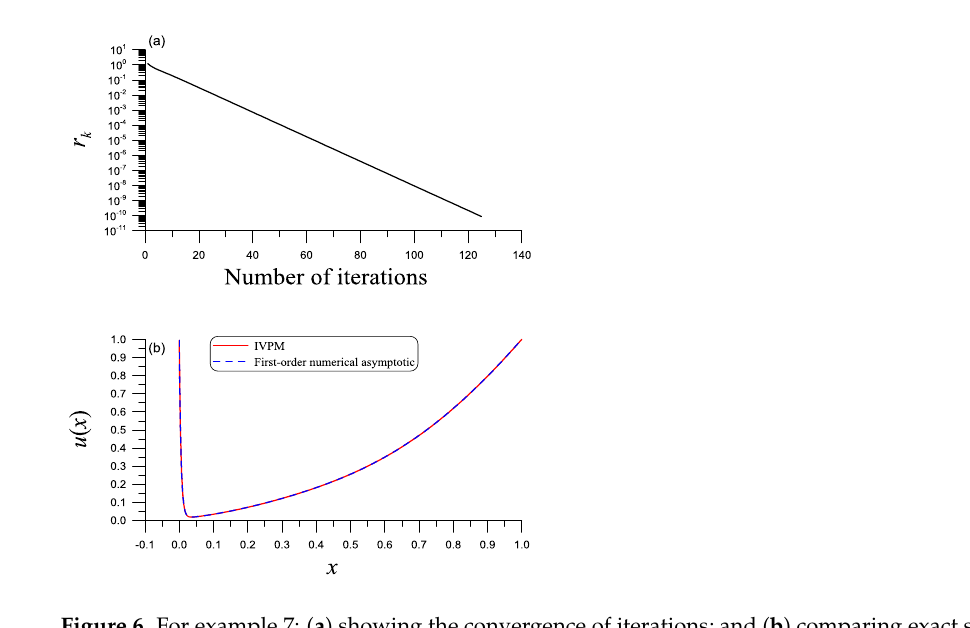
Figure 6. For example 7: ( a ) showing the convergence of iterations; and ( b ) comparing exact solution and the present first-order solution. Table 4. For example 7, comparing ME1 and ME2 for different ε .